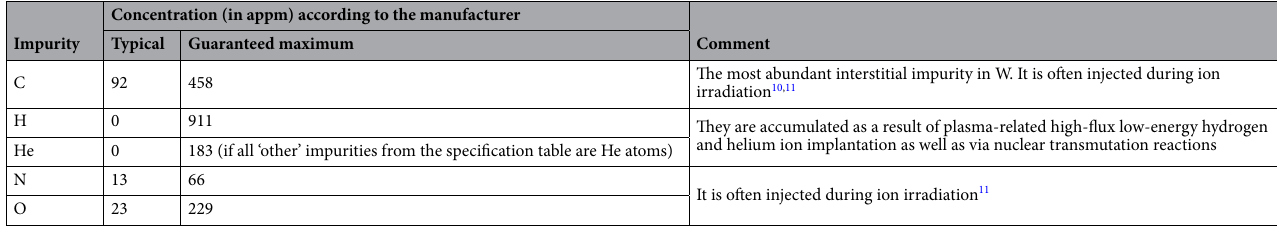
Table 1. The list of interstitial impurities contained in a W grade manufactured by Plansee 8